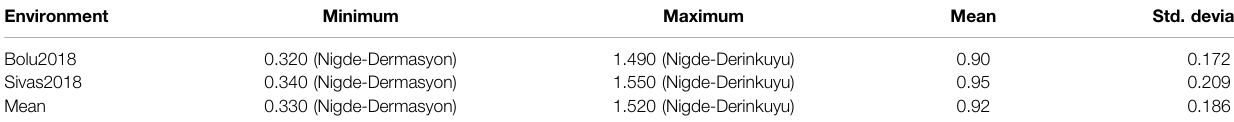
TABLE 2 | Minimum, maximum and mean Mg (mg kg − 1 ) contents in Turkish common bean germplasm under multi-year/environments.